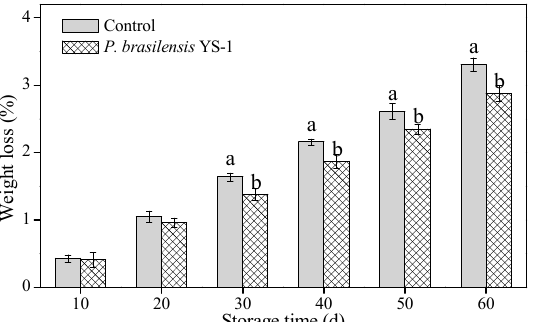
Figure 2. Effect of P. brasilensis YS-1 treatment on the weight loss of citrus fruits stored at 5 ± 0.5 °C for 60 d. Vertical bars represent the mean ± SE ( n = 10). Letters indicate statistical differences according to an independent samples t -test ( p < 0.05) on each storage day.